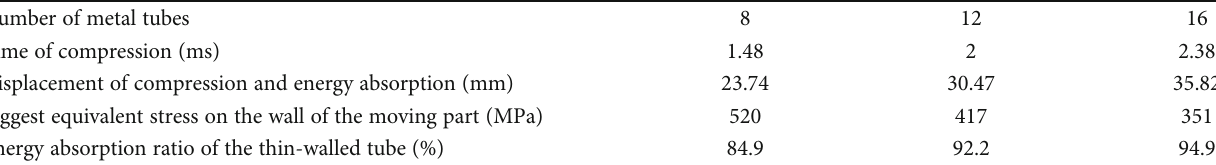
Figure 14: Displacement-time curves of the ascending object for stacked tubes. A: 8 metal tubes; B: 12 metal tubes; C: 16 metal tubes. Table 5: Simulation results: energy absorption process parameters for di ff erent numbers of metal tubes.